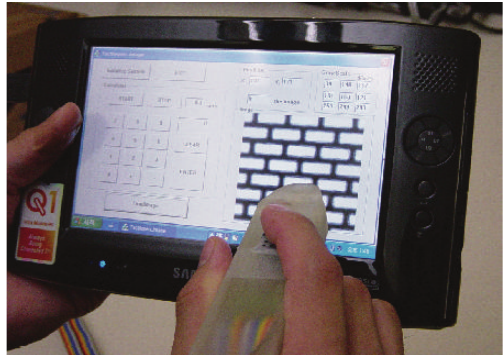
Figure 13: Tactile image display on a touchscreen.